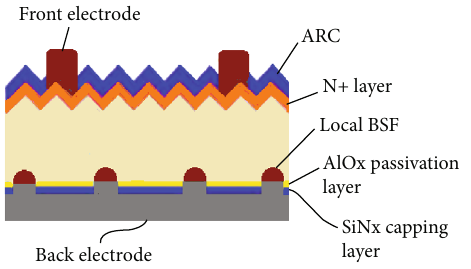
Figure 1: Structure of a crystalline silicon PERC cell commonly fabricated by